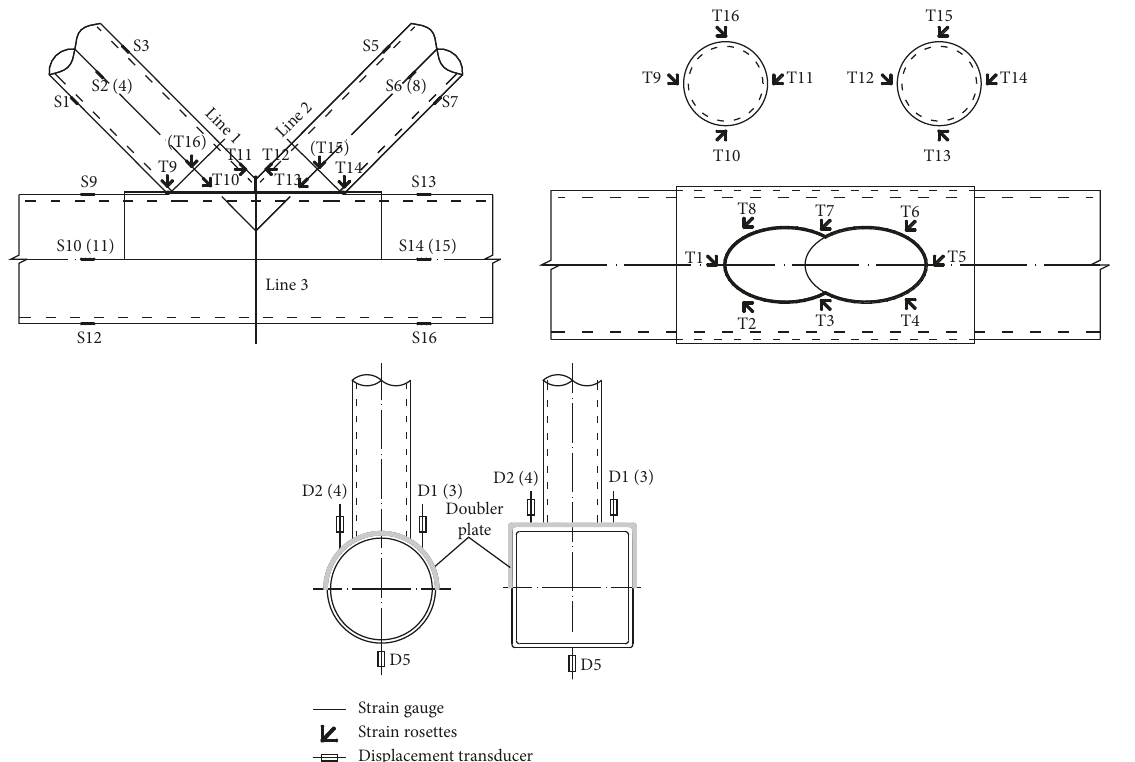
Figure 4: Measurement points of